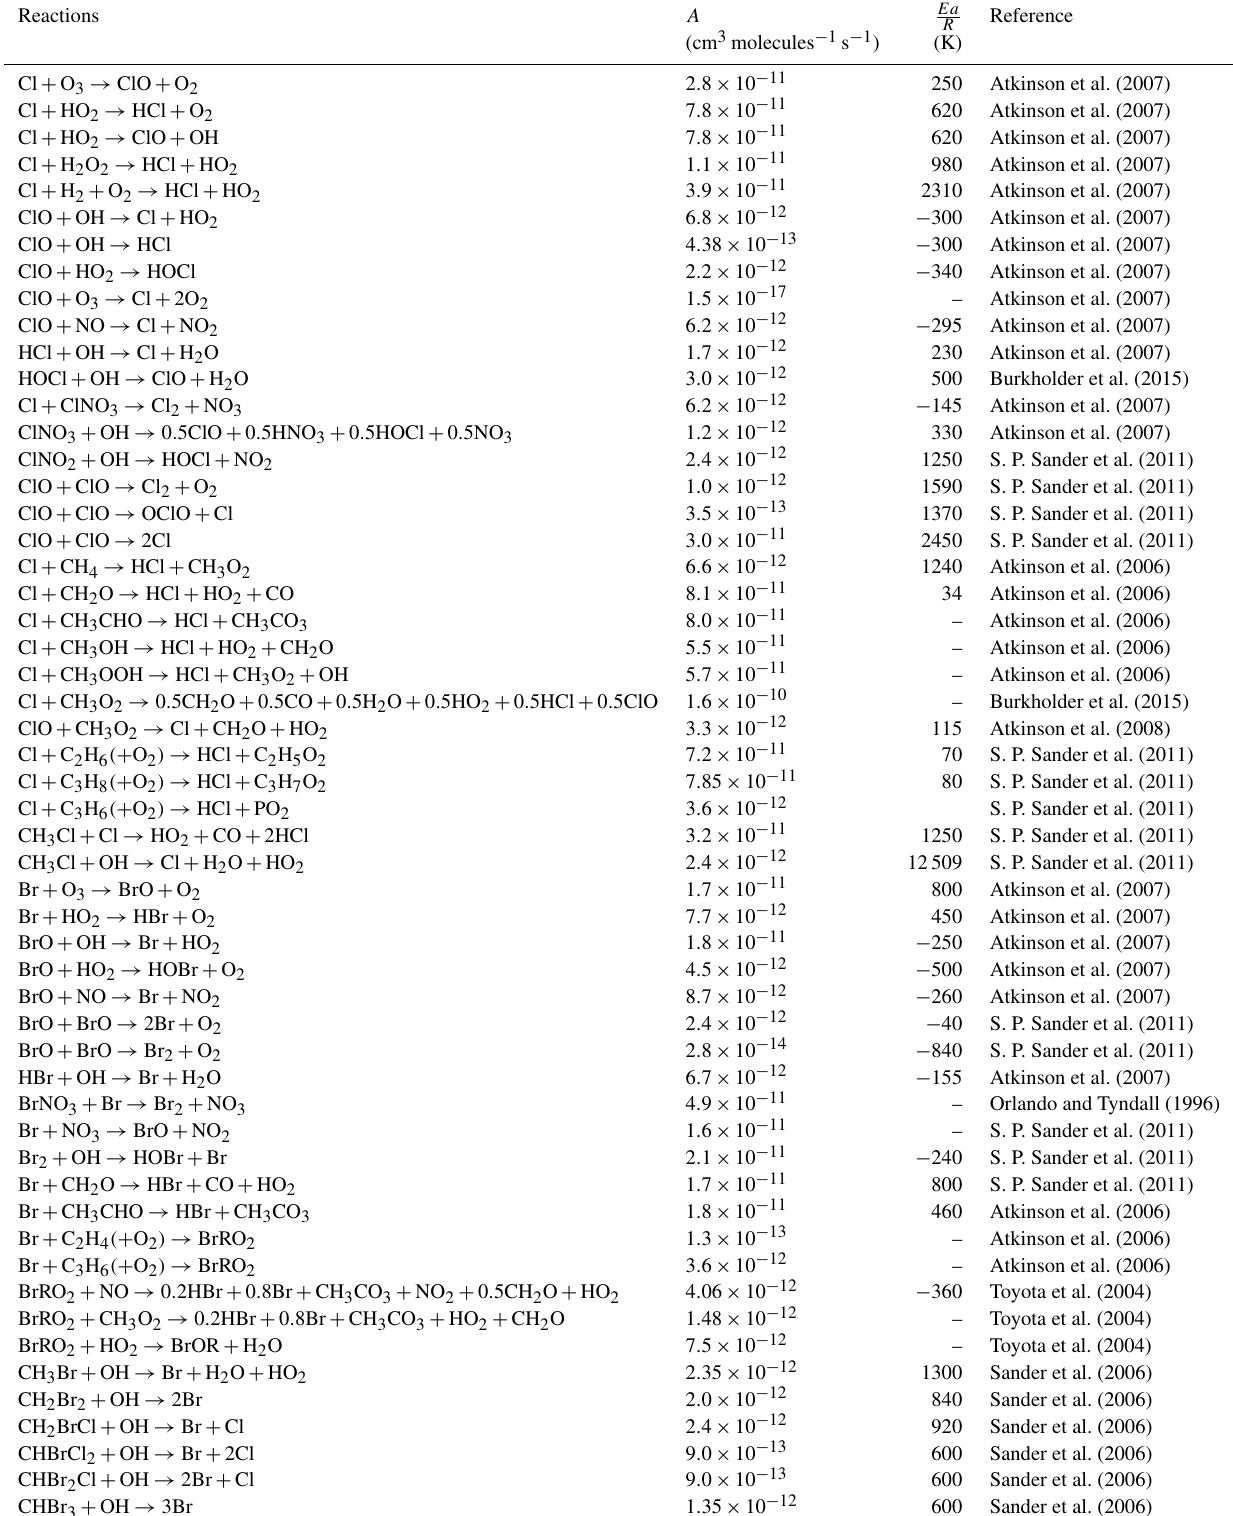
Table 2. Bimolecular and thermal decomposition halogen reactions included in WRF-Chem. These reactions are given in the Arrhenius form − Ea with the rate equal to A × e RT